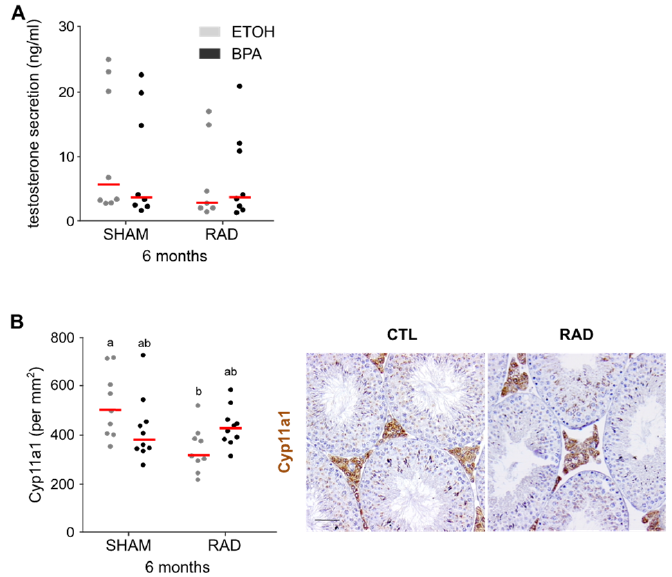
Figure 5. RAD exposure in utero alters steroidogenesis in adult mice. ( A ) Plasma testosterone concentration in control (CTL) and BPA- and/or RAD-exposed adult mice. Each dot represents an individual mouse and medians are represented as horizontal red lines (no statistically significant difference was observed after two-way ANOVA, n = 7–8). ( B ) Number of CYP11A1 positive cells per mm 2 of testis from unexposed and exposed adult mice. Each dot represents an individual mouse and medians are represented as horizontal red lines. Different letters indicate significant differences between groups (two-way ANOVA, Tukey’s multiple comparisons test, p < 0.05, n = 9–10). Right panels show representative pictures of the staining in control (CTL) and RAD-exposed (RAD) gonads. Bars represent: 50 µ